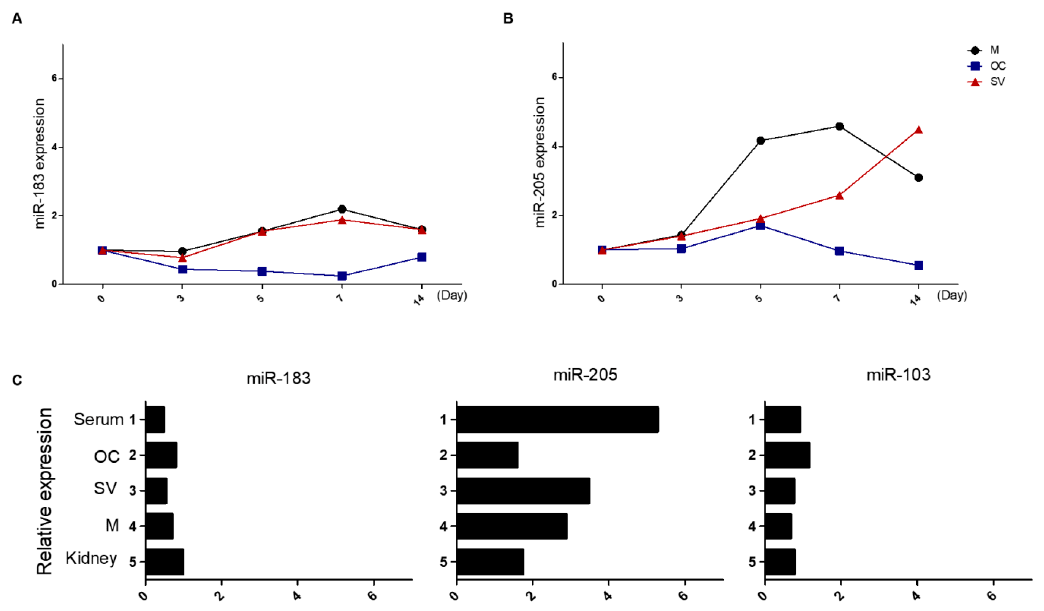
Figure 3. Comparison of miR-205 and miR183 expression levels in the mouse ear. The expressions of miR-183 ( A ) and miRNA-205 ( B ) in the stria vascularis (SV), organ of Corti (OC), and modiolus (M) were examined using qRT-PCR. The expression of miR-205 in the stria vascularis in the ototoxicity-induced mouse group gradually increased and was highest at day 14. ( C ) The levels of miR-183, miR-205, and miR-103 in the serum at day 14 after the induction of ototoxicity was compared with levels in the microstructures of the cochlea and kidney. Levels of miR-205 was highest in the serum, and levels in the stria vascularis were also increased. No differences were observed for the levels of miR-183 and miR-103. p < 0.0001.